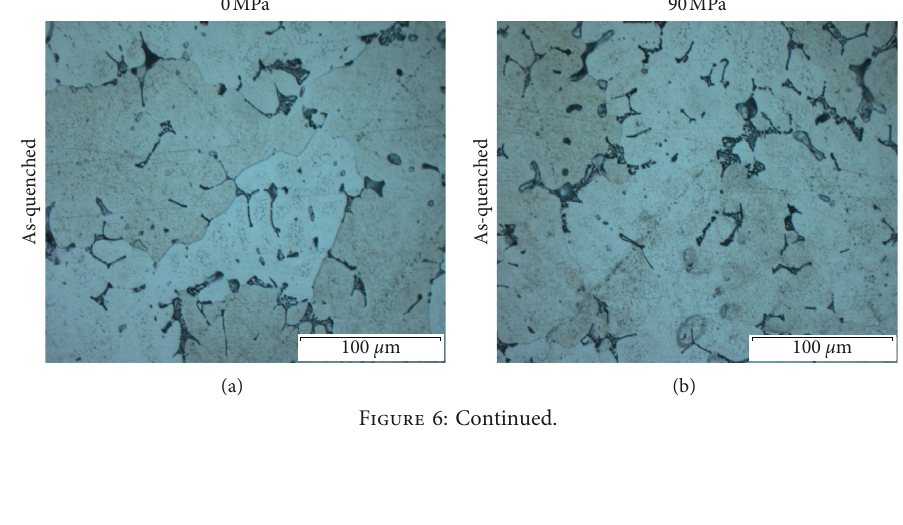
0MPa, (b) P 30MPa, (c) P (cid:31) (cid:31)